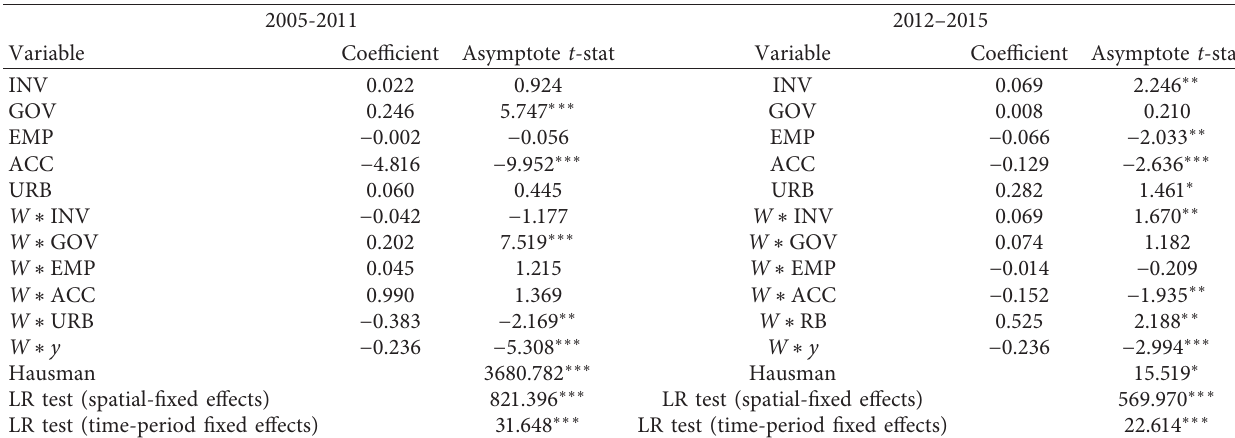
Figure 2: Accessibility of the study area in year 2015. (a) Normal rail and (b) Table 3: Regression results of two periods.